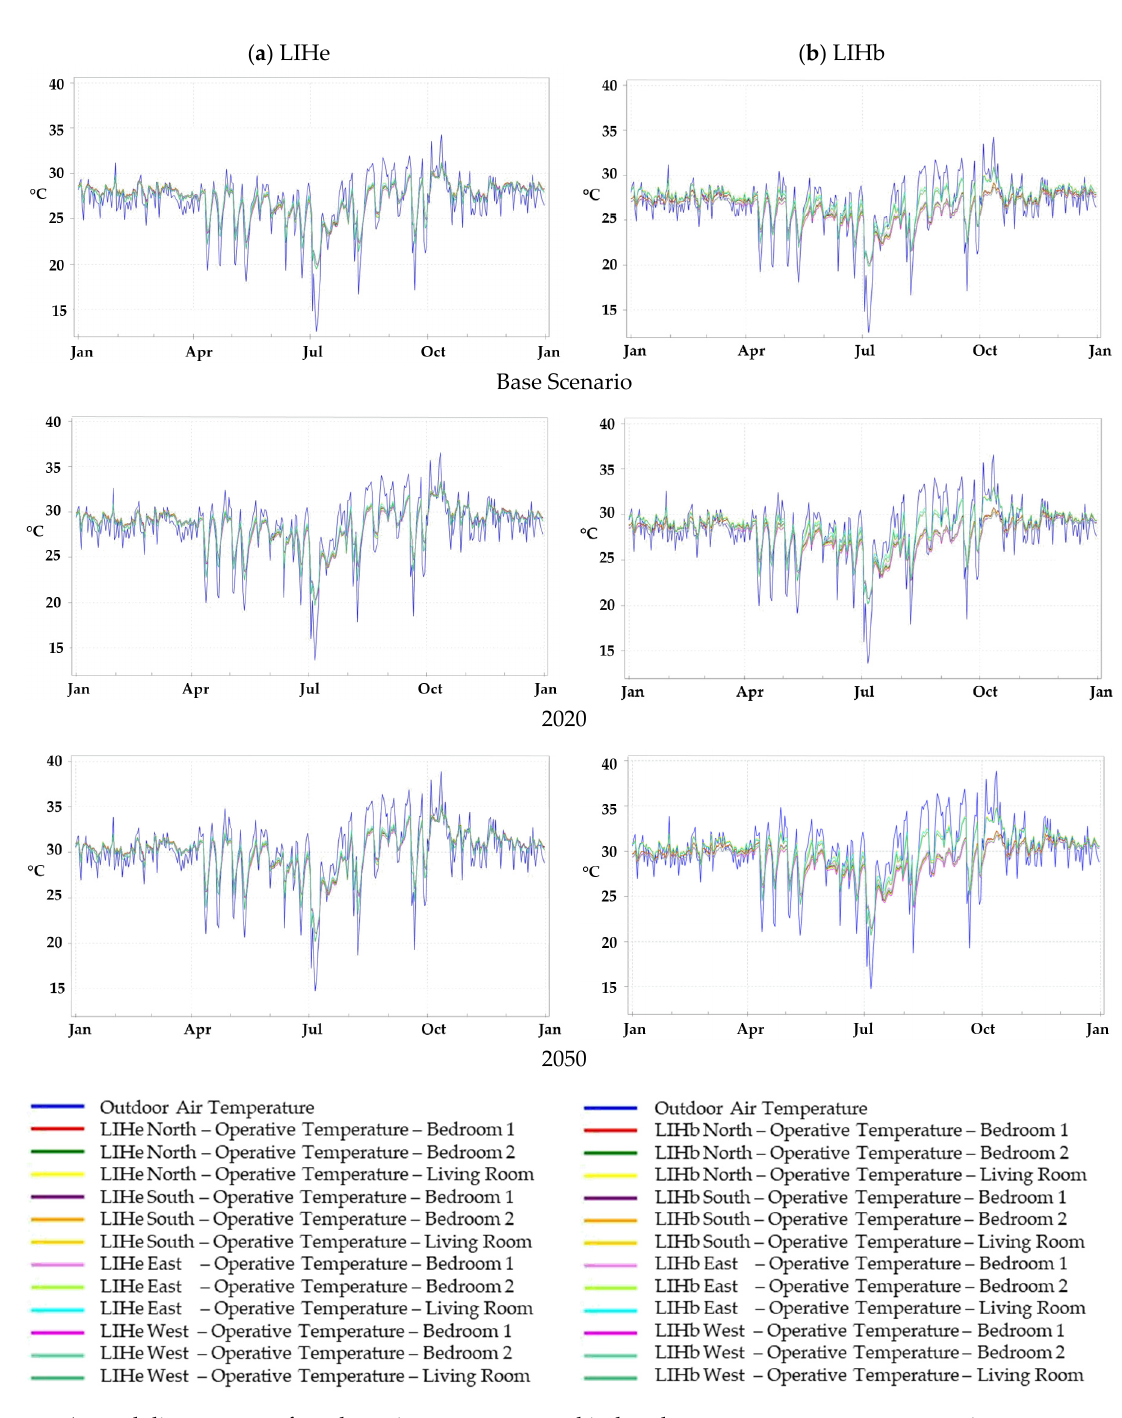
Figure 7. Annual diary course of outdoor air temperature and indoor long permanence rooms operative temperatures for the base and future scenarios in ( a ) LIHe and ( b )